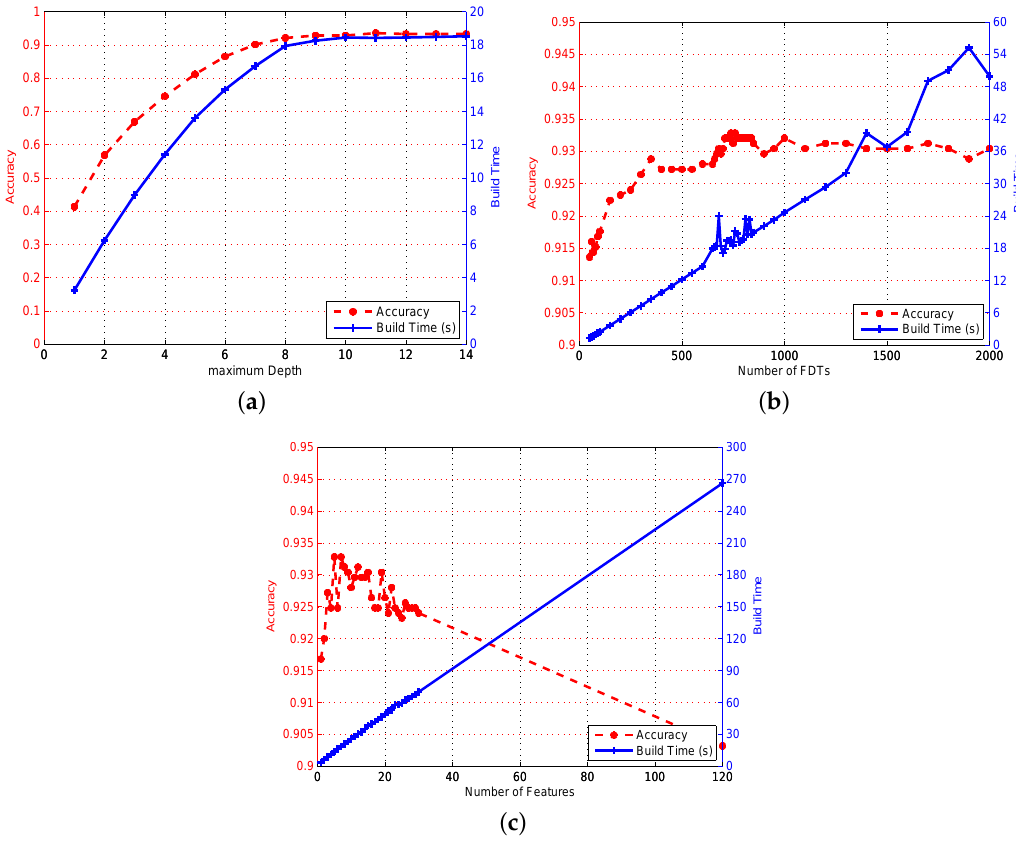
Figure 10. The classification accuracy and build time of RFFP with different system parameters. ( a ) with different max depths of FDT. ( b ) with different number of FDTs utilized in RFFP. ( c ) with different number of features chosen for feature selection stage in